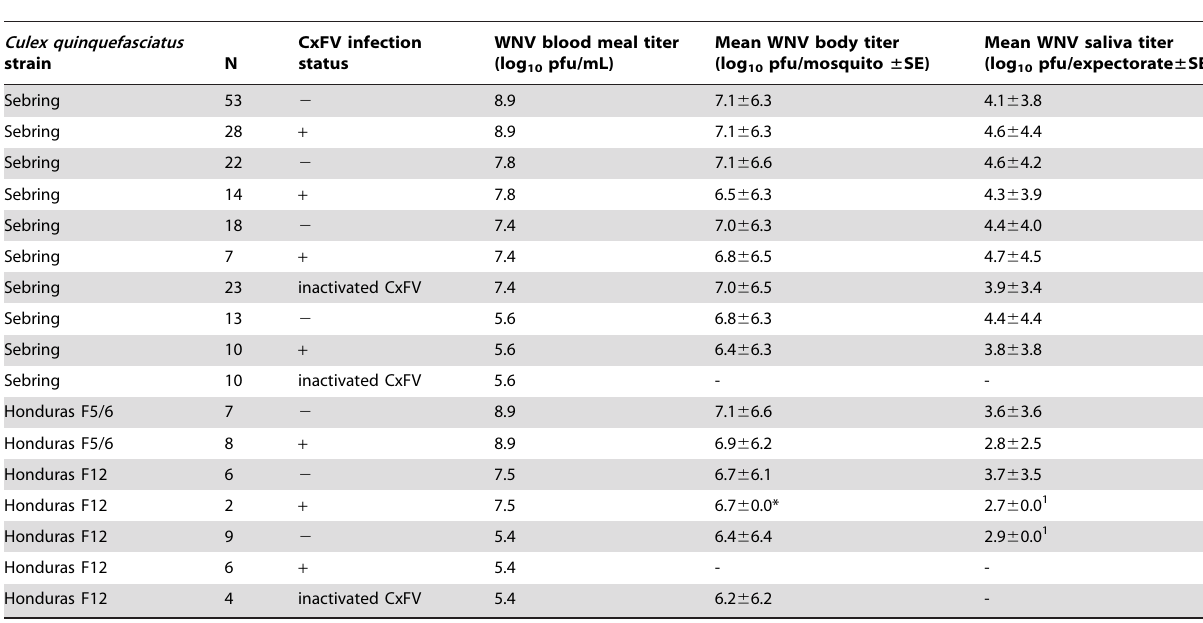
Table 3. Mean WNV titer in Cx. quinquefasciatus bodies and salivary expectorates of specimens either infected or uninfected intrathoracically with CxFV